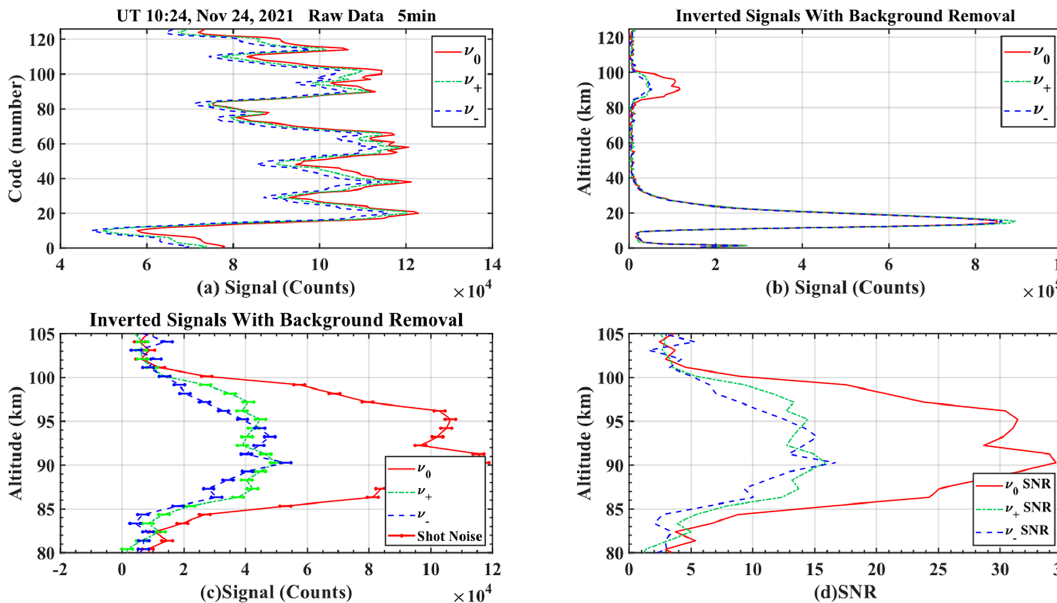
Figure 4. Profiles of (a) raw signals arranged in M-code sequence with 1.05km spatial and 5min temporal resolutions on 24 November 2021, (b) inverted signals with background subtracted, (c) inverted signals of only the sodium layer region, and (d) the signal-to-noise ratio of v 0 , v + , and v − frequencies of